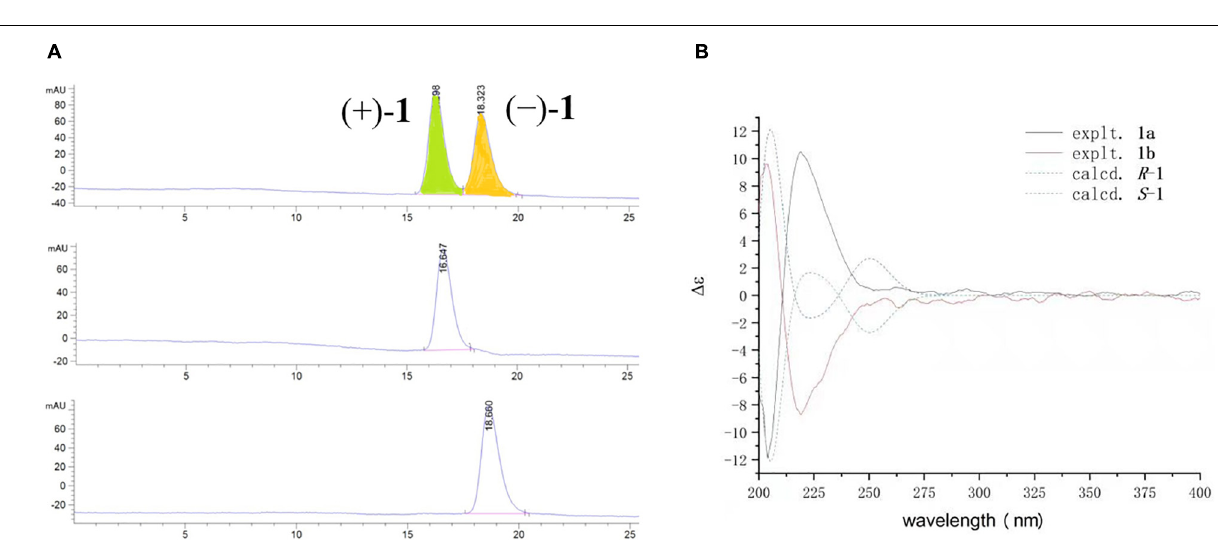
FIGURE 4 | (A) Chromatogram of the chiral HPLC analysis of 1. (B) Experimental and calculated ECD spectra of ( ± ) − 1 in